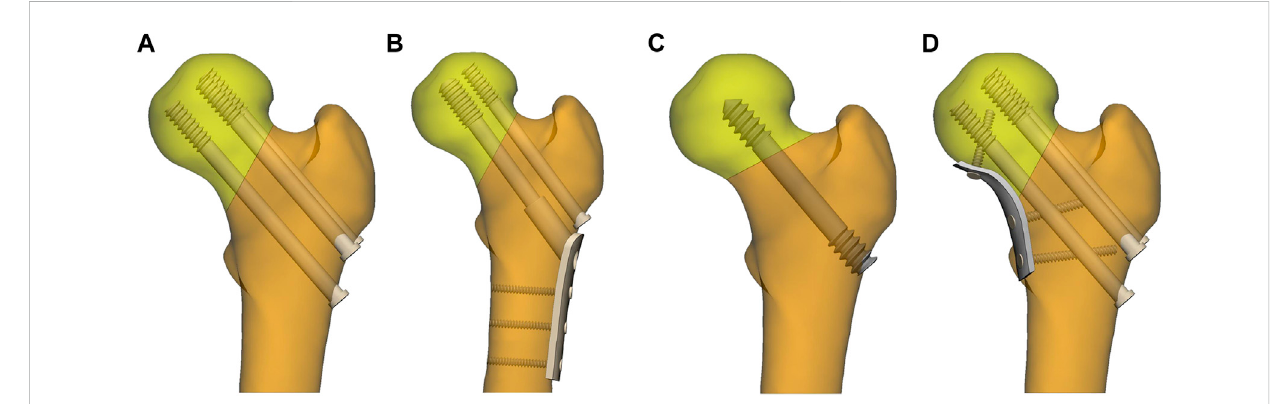
FIGURE 1 Internal fi xationoffemoralneckfractures. (A) threeparallelcannulatedcompressionscrews(CCS); (B) dynamichipscrewsandanti-rotationscrews; (C) porous tantalum screws (PTS); (D) three parallel cannulated compression screws and medial buttress plate (MBP).